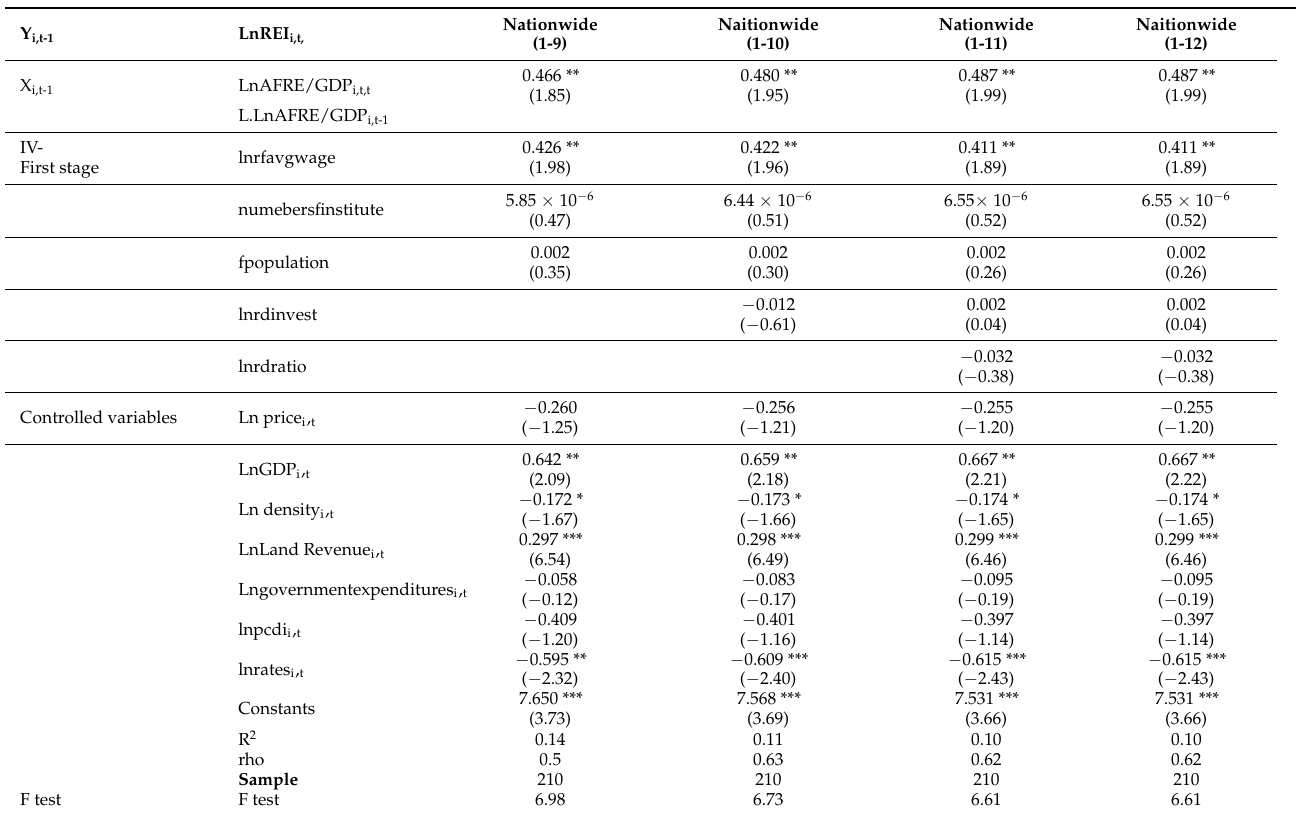
Table 5. First-stage OLS estimation